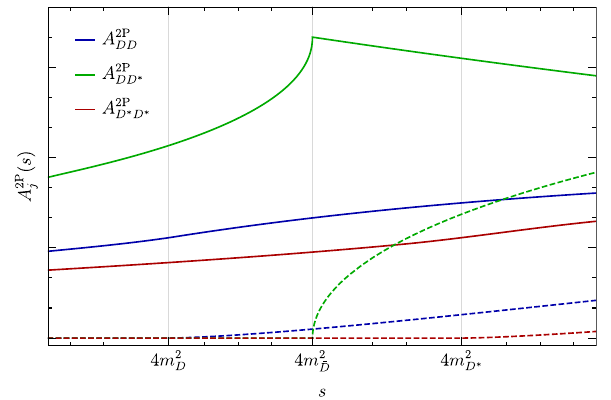
Fig. 2 Real (solid) and imaginary (dashed) parts of the normalised hadronic two-particle contributions to Y c ¯ c ( q 2 ) , as defined in Eq.